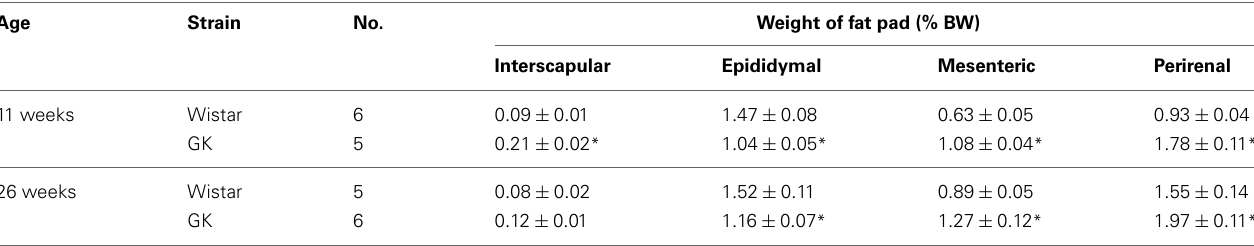
Table 1 | Interscapular, epididymal, mesenteric and perirenal fat weights (% body weight) in control Wistar and diabetic GK rats at 11 and 26 weeks of